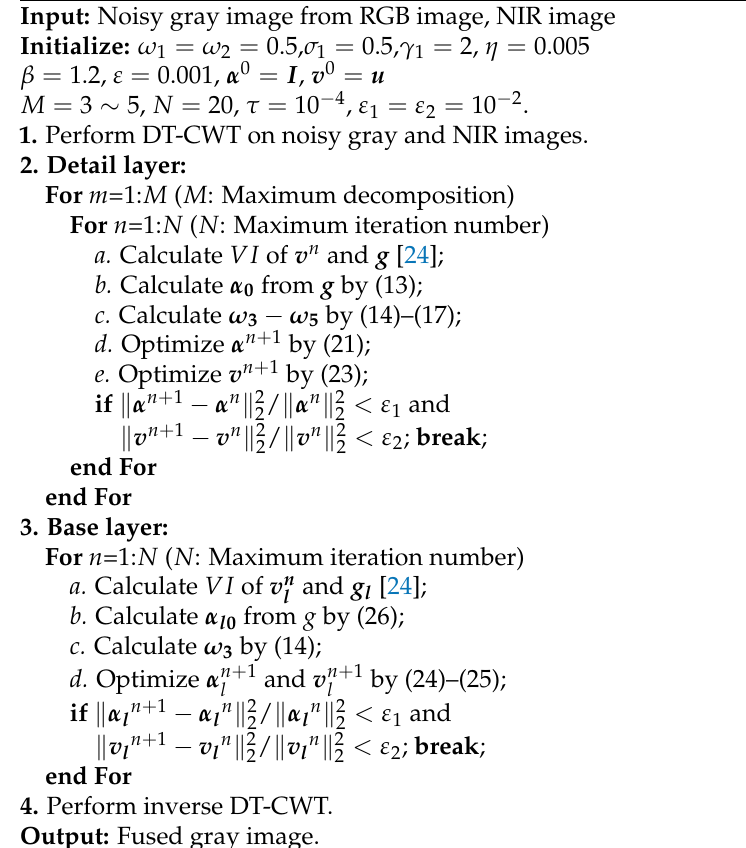
Algorithm 1 Multi-scale fusion and denoising of NIR and RGB images.